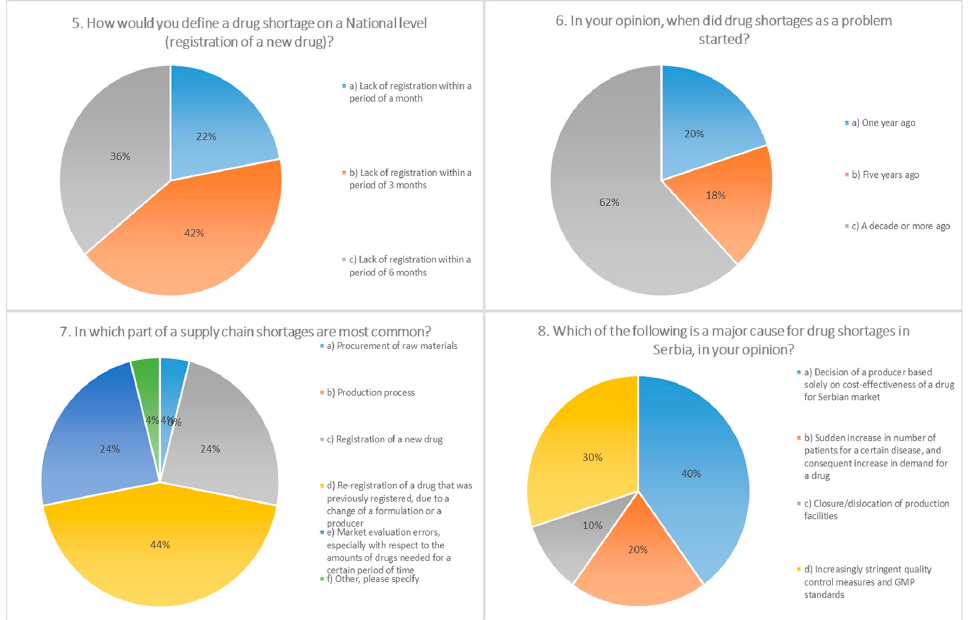
Figure 2. Questions 5 to 8 from a 15-question survey, distributed electronically to community pharmacies in 23 cities in Serbia on behalf of the Faculty of Pharmacy, Novi Sad. The survey was available for completion between February and April, 2019. The survey was anonymous, as contact information was not requested. Data collected from the survey included demographic information. The majority of the questions were multiple choice, allowing respondents to select a pre-specified answer. A total of 500 surveys were administered to community